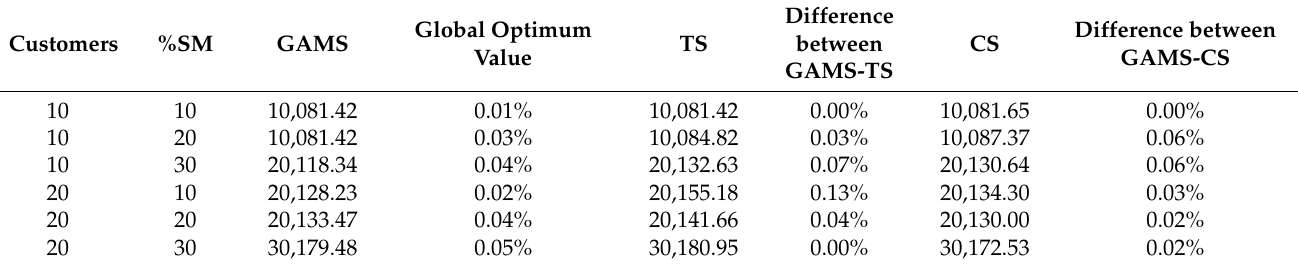
Table 1. Results GAMS and